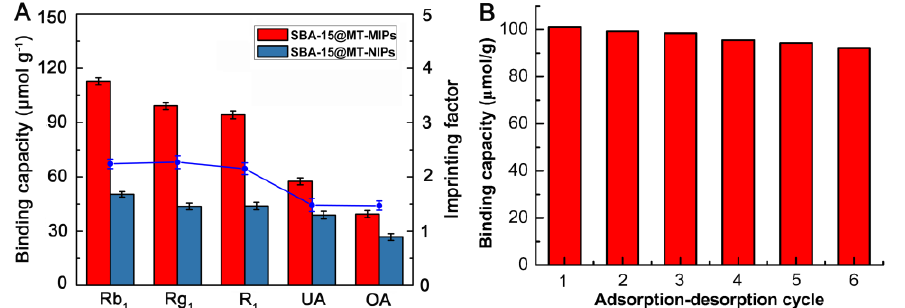
Figure 7. ( A ) Selective adsorptions of SBA-15@MT-MIPs and SBA-15@MT-NIPs towards Rb 1 , Rg 1 , R 1 , UA and OA standard solution with corresponding imprinting factors; ( B ) Reusability of SBA-15@MT-MIPs.